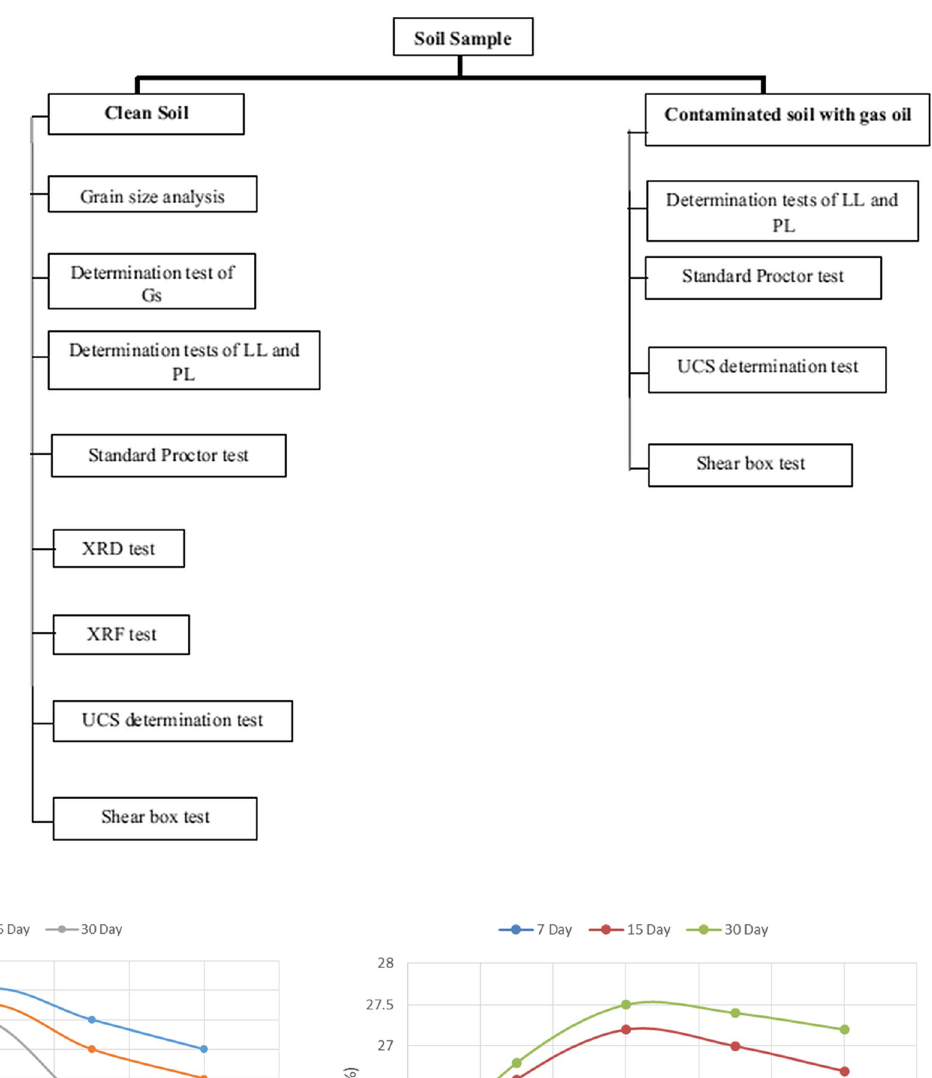
Fig. 6 Flowchart of the laboratory-testing procedure